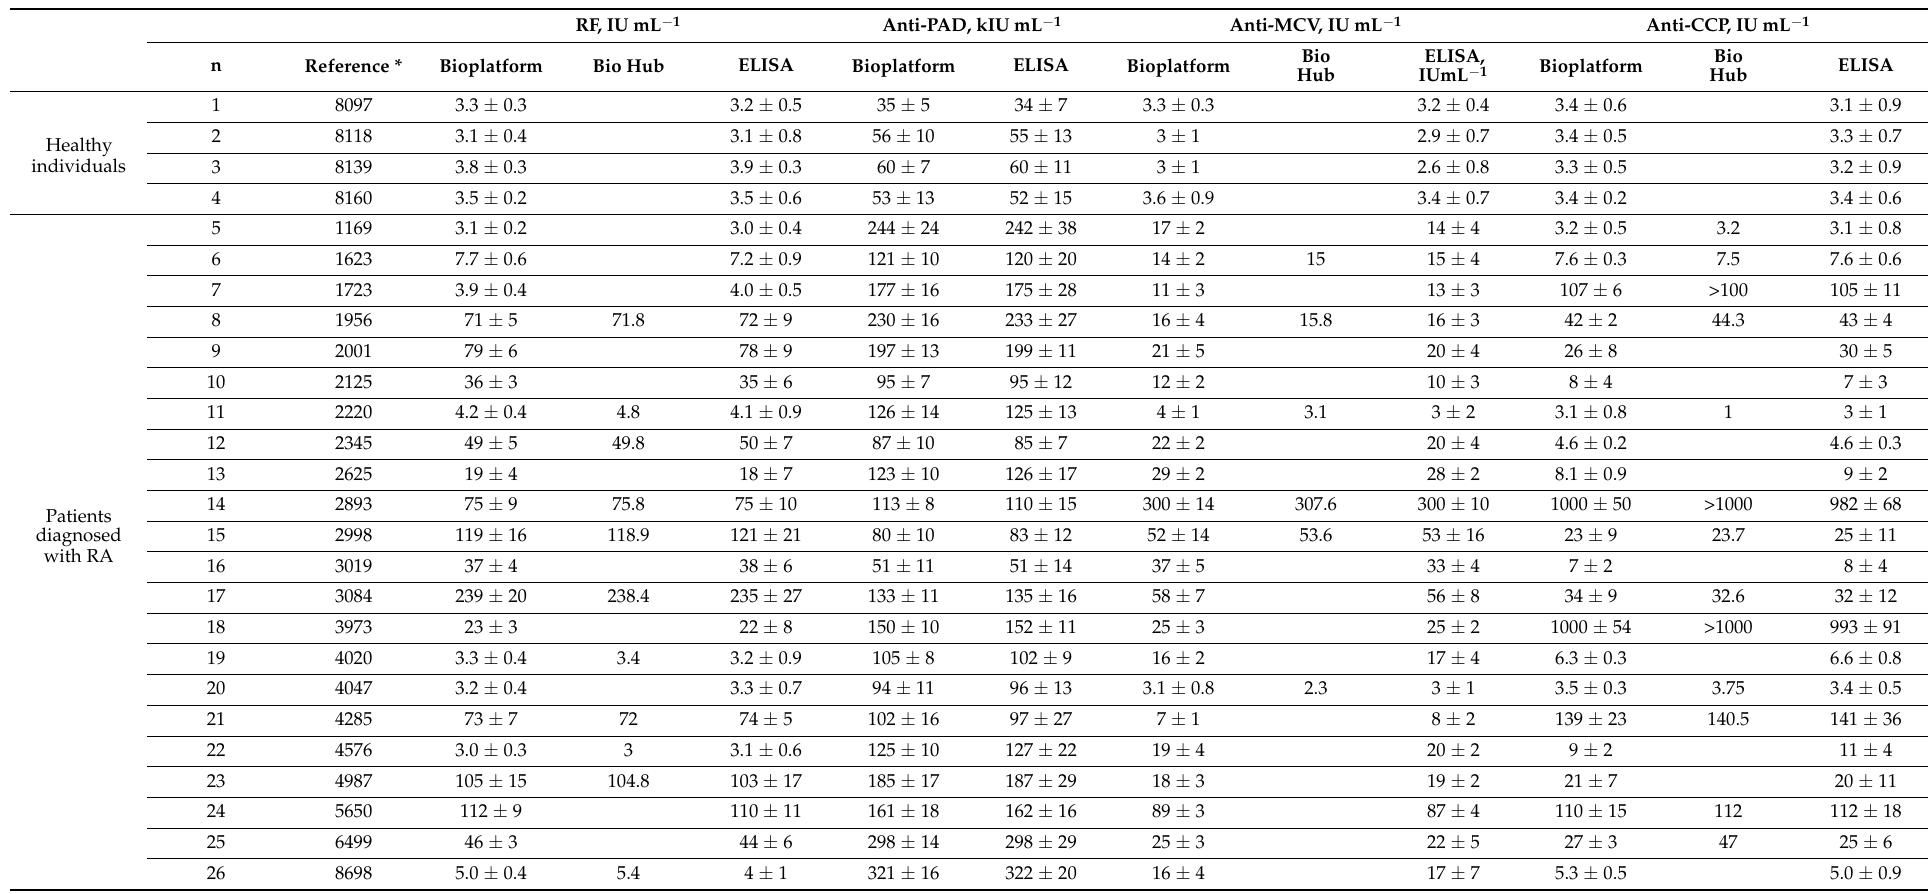
Table 3. Determination of the endogenous concentrations of the four autoantibodies in serum samples of healthy individuals and patients diagnosed with RA, with the quadruple bioplatform and ELISA, and certified concentrations from Central BioHub ® Product